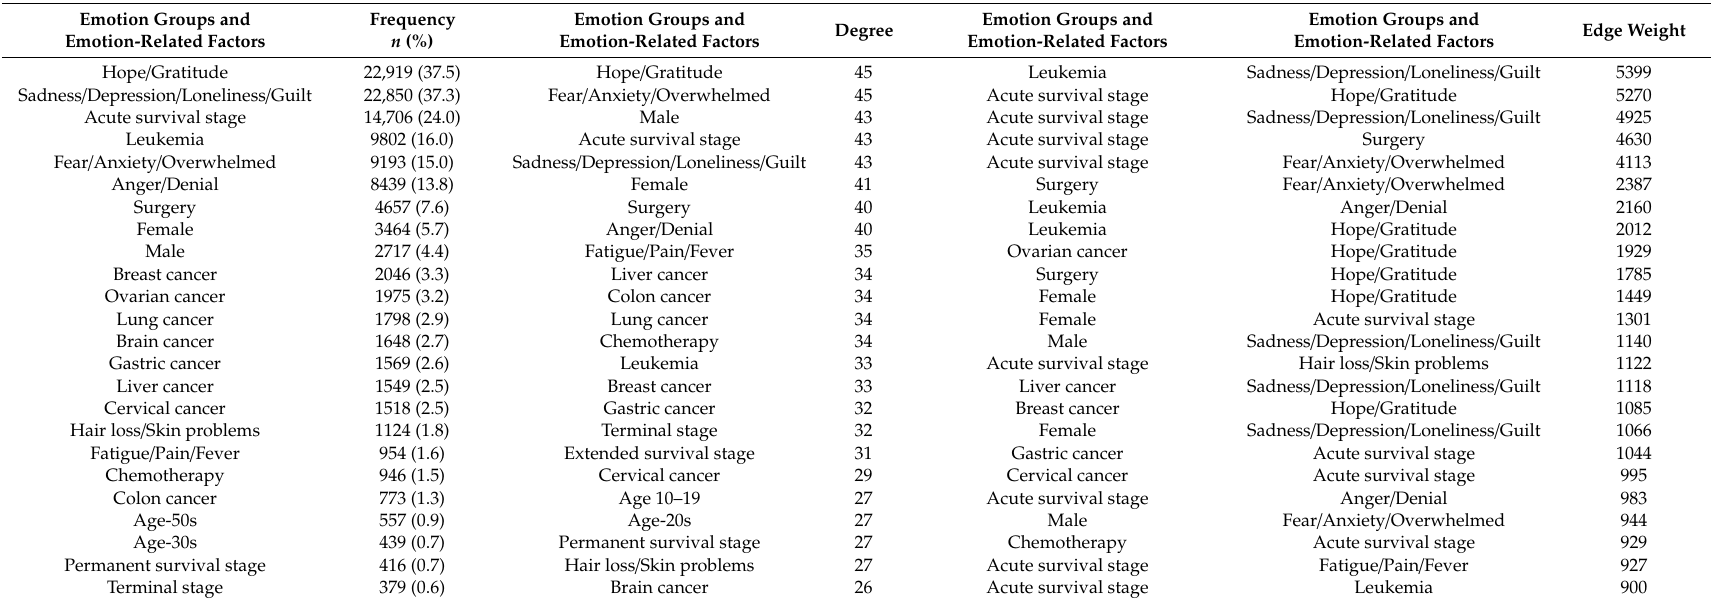
Table 4. Top 24 nodes with degree and edge weight on